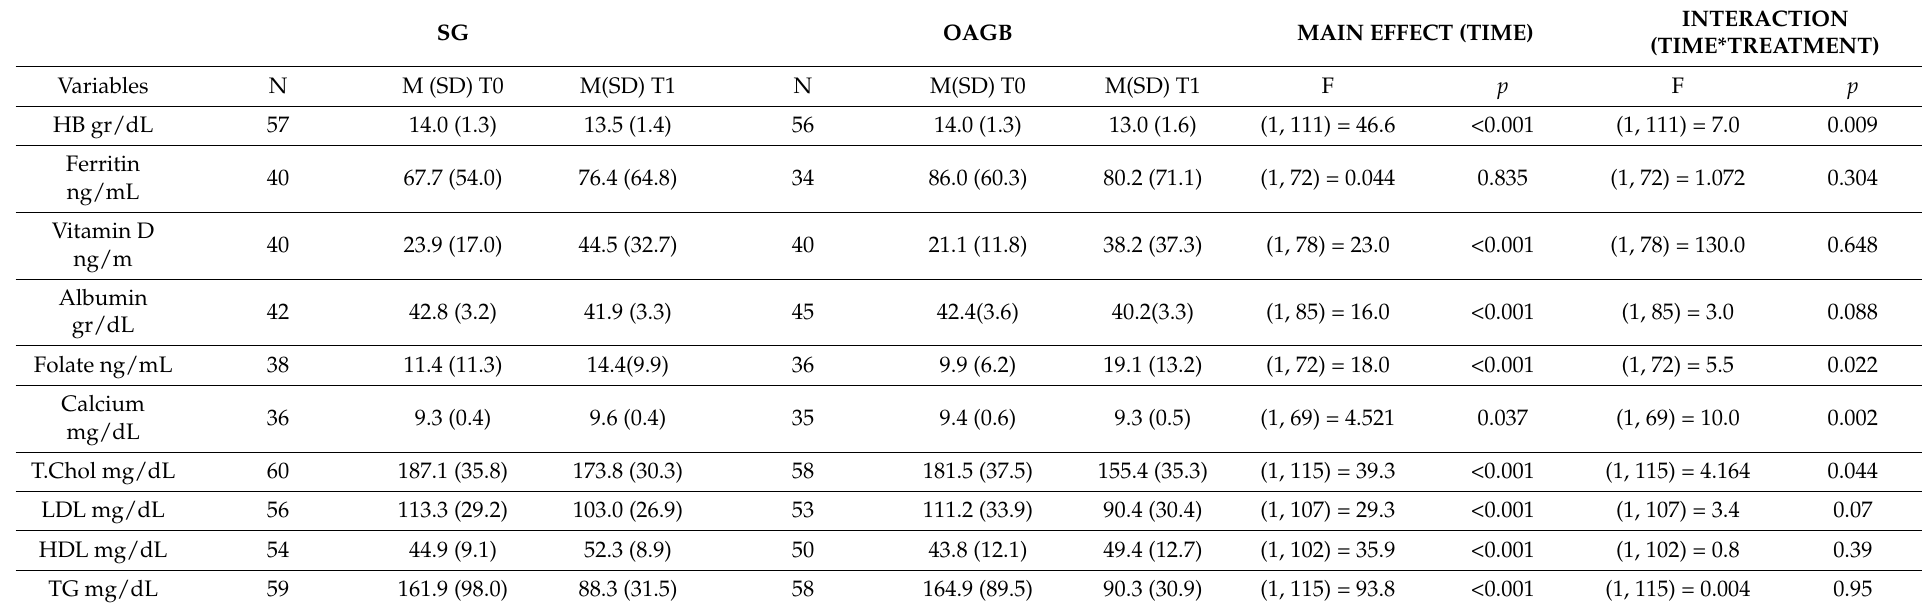
Table 4. Comparison of outcomes between the two groups, one year after surgery.